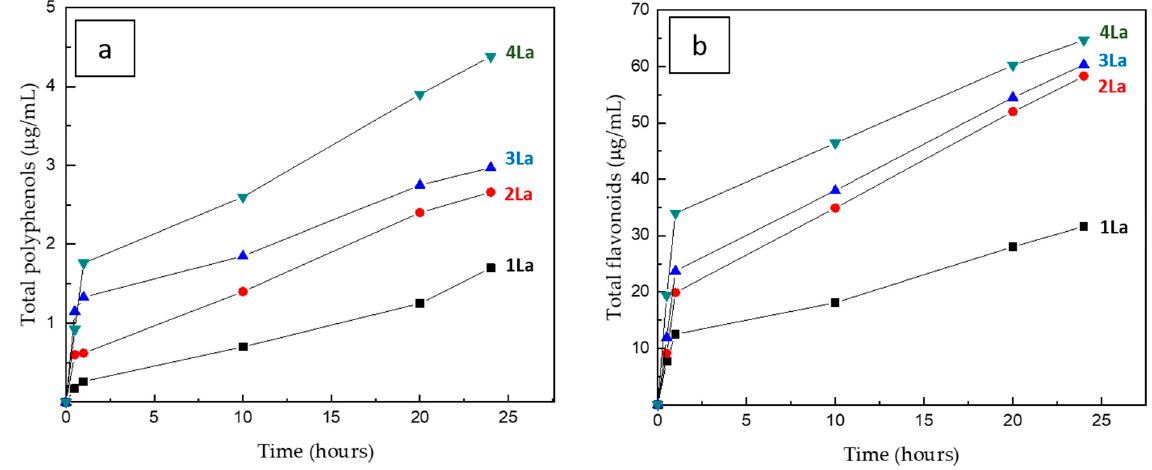
Figure 5. Kinetics of total polyphenols ( a ) and total flavonoids ( b ) released from plasters: 1La, 2La, 3La, and 4La. Polyphenols are generally considered moderately water-soluble compounds, while most flavonoids are present in plants bound to sugars in the form of β -glycosides, which are readily soluble in water. This fact clearly determines a big difference between their release kinetics, the flavonoids being much faster in passing into an aqueous environment.